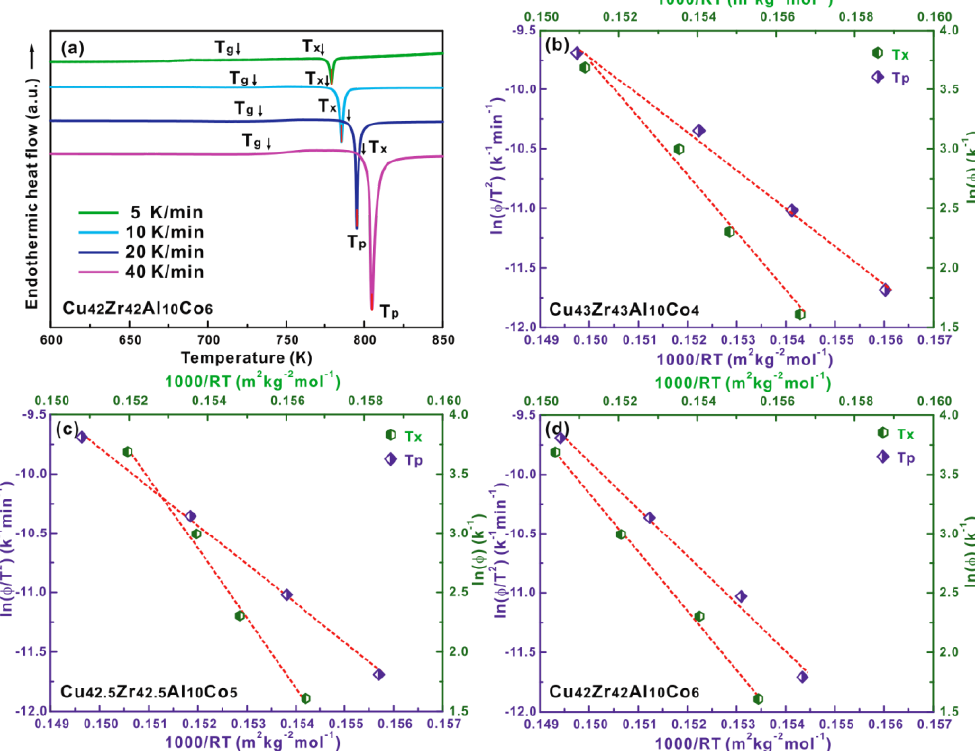
Figure 4. ( a ) DSC curves for the (Cu 0.5 Zr 0.5 ) 84 Al 10 Co 6 BMGs at different heating rates, and the Ozawa and Kissinger plots based on the isochronal DSC measurements for (Cu 0.5 Zr 0.5 ) 90− x Al 10 Co x ( x = ( b ) 4, ( c ) 5, and ( d ) 6 at. %) samples.